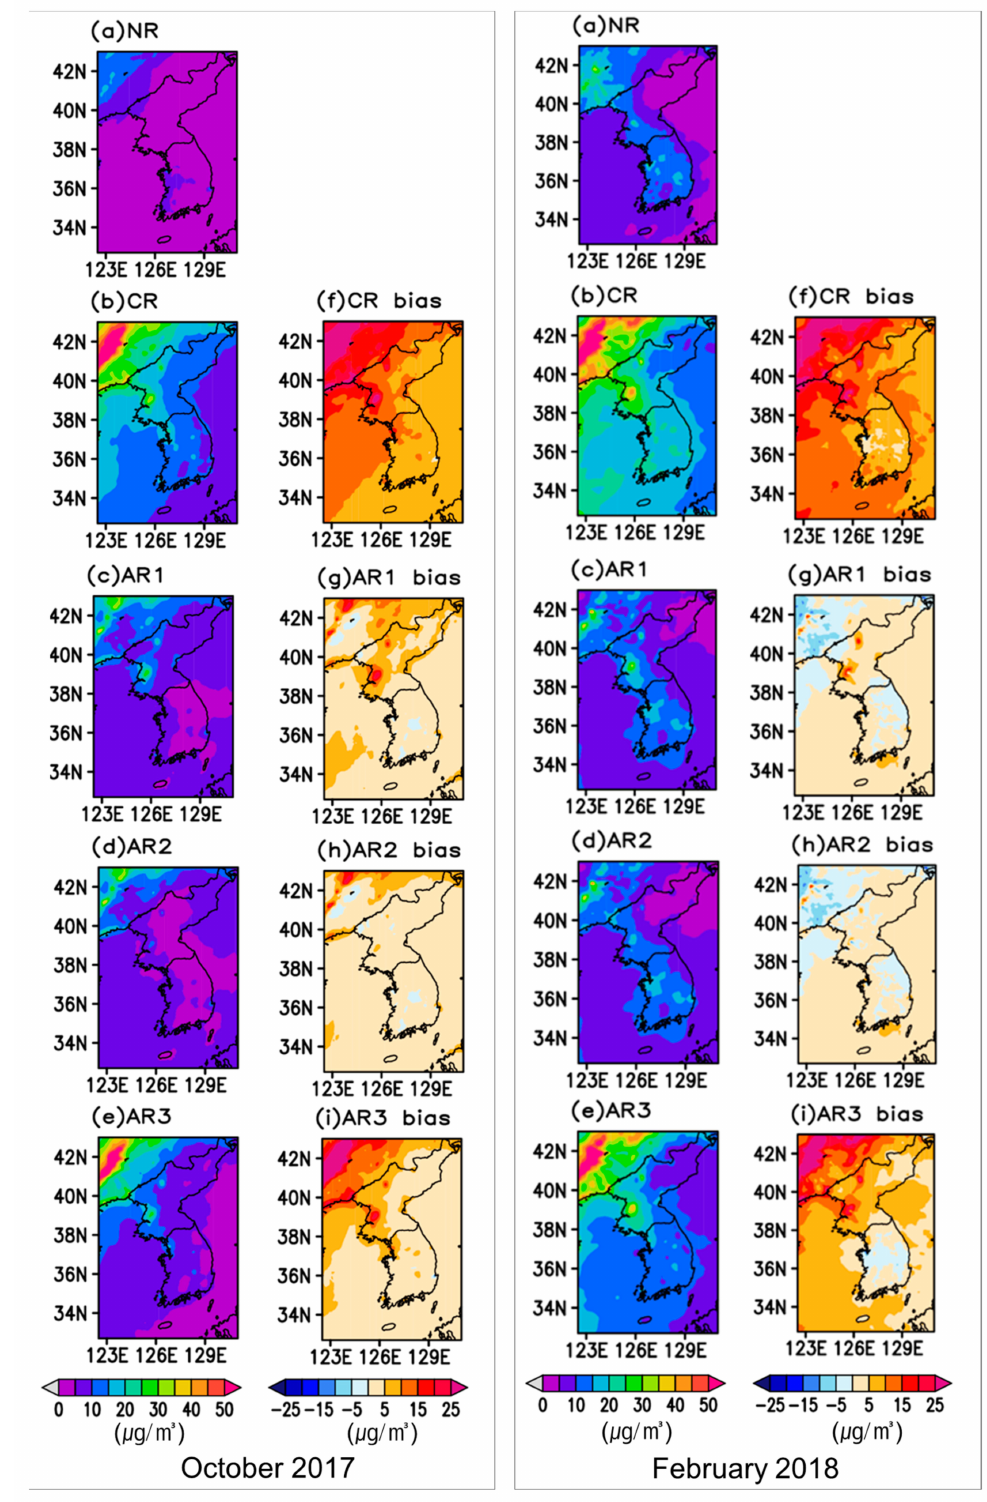
Figure 6. The distribution of the average PM 2.5 concentrations on the Korean Peninsula for the NR, ARs, and the AR mean bias against the NR PM 2.5 at 00:00 UTC from October 2017 to February 2018 (unit: µ g/m 3